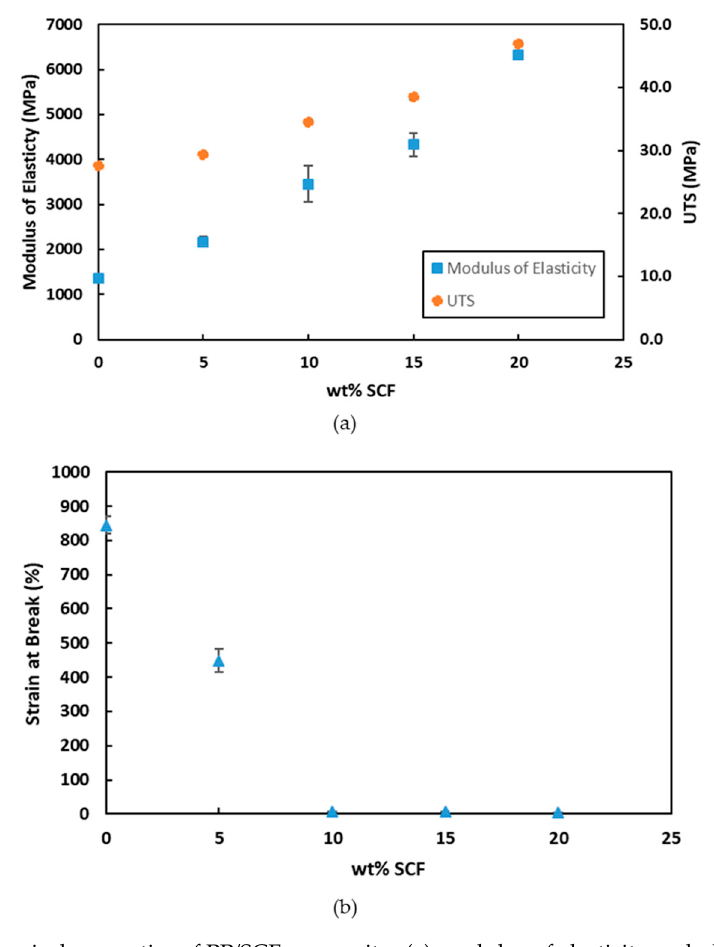
Figure 9. Mechanical properties of PP / SCF composites ( a ) modulus of elasticity and ultimate tensile strength (UTS) and ( b ) strain at break vs. wt % SCF.